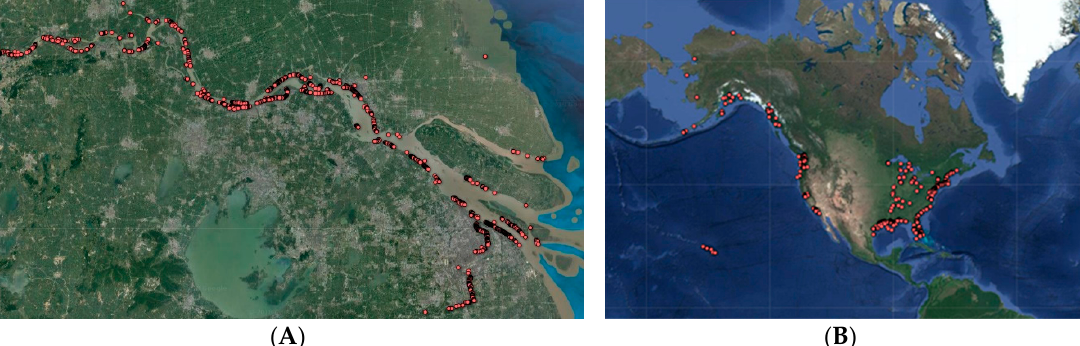
Figure 7. ( A ) Berth grid cells / OD events detected along the lower reaches of Yangtze River. ( B ) Berth grid cells of ports discovered in US. Each red circle represents one grid cell corresponding to one or multiple historical port call events.